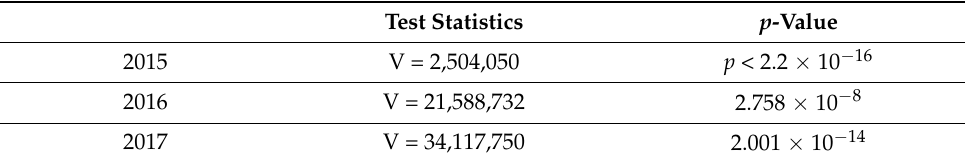
Table 6. Sign Test Results.